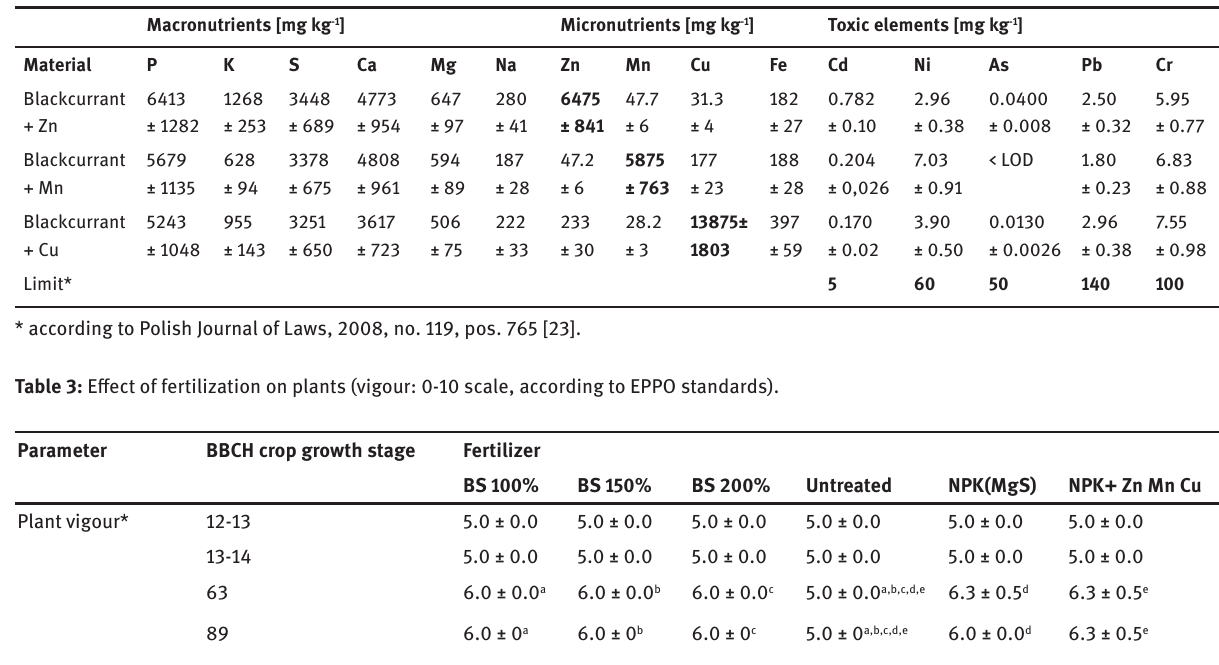
Table 2: Results of multielement content of macronutrients, micronutrients and toxic elements in new biocomponents. Mean with standard deviations.